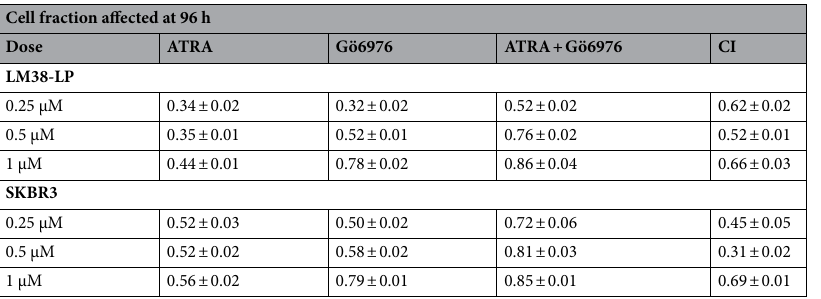
Table 1. Proliferation assay, determination of the combination Index (CI). LM38-LP and SKBR3 cells number was assessed 96 h after treatments with ATRA (0.25–1 µM) and/or Gö6976 (0.25–1 µM). Each data point represents the mean ± standard error of three independent experiments. CI < 0.7 indicates synergism, CI > 0.7 and CI < 1 indicates additivity, and CI > 1 denotes